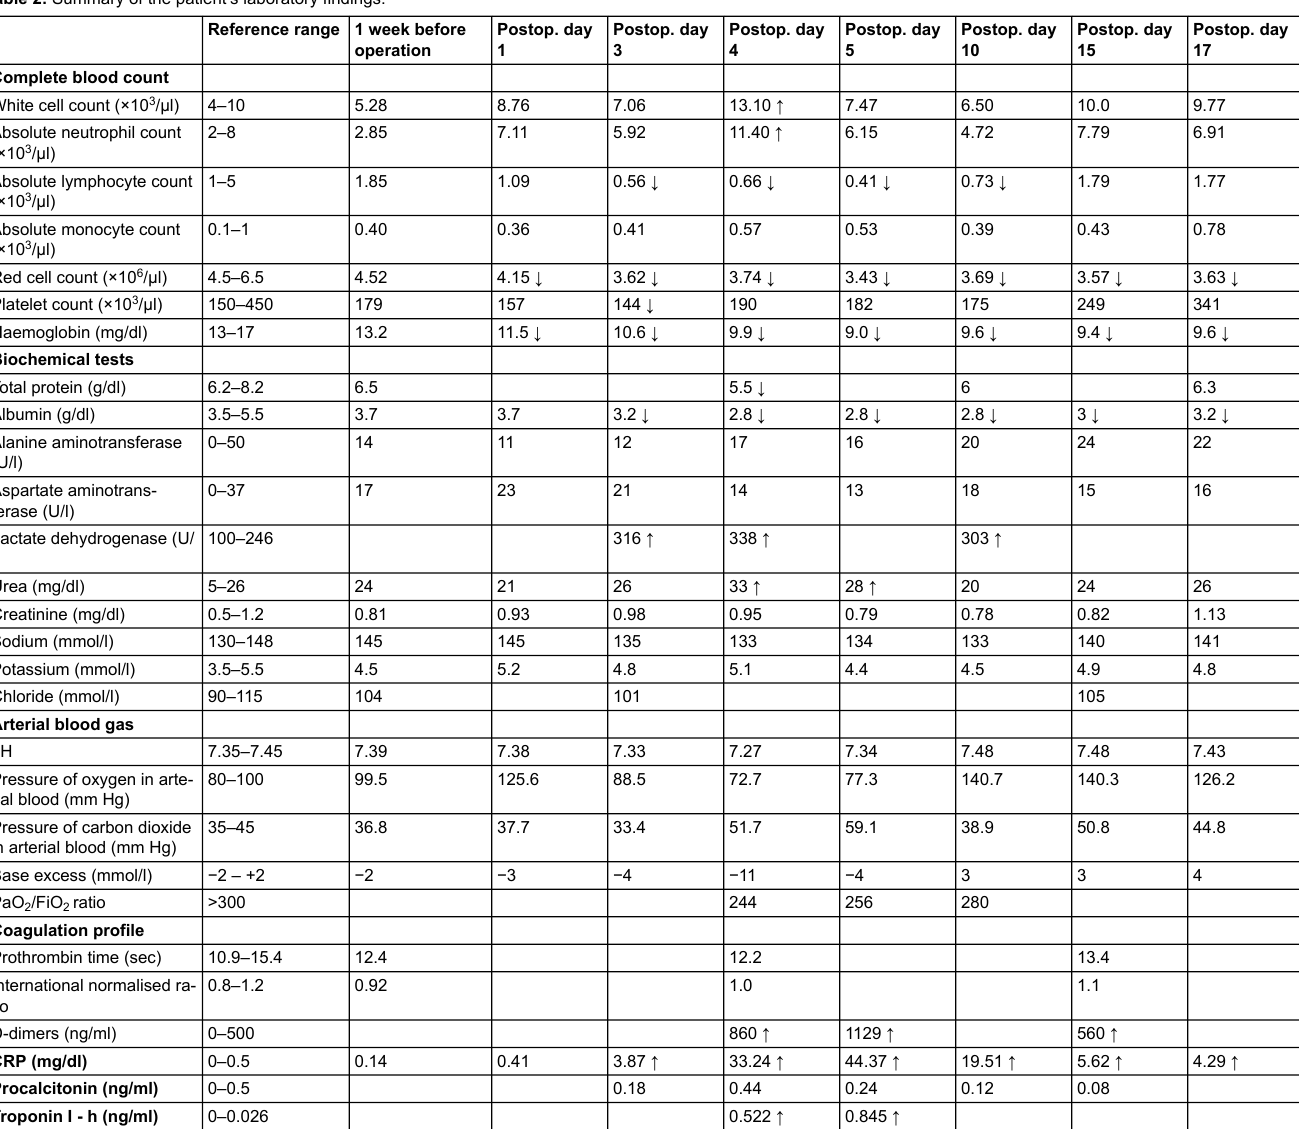
Table 2: Summary of the patient’s laboratory